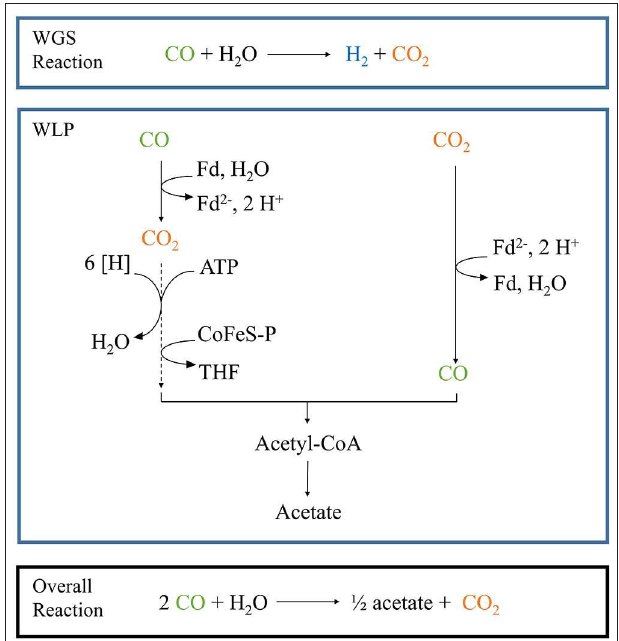
FIGURE 1 | Schematic pathway of the combined WGS reaction and Wood-Ljungdahl pathway. The blue boxes depict each pathway separately, while the black box shows the result of the combined reactions in our particular set-up. Fd, oxidized ferredoxin; Fd 2 − , reduced ferredoxin; [H], reduction equivalents. Dotted lines depict a multiple-step